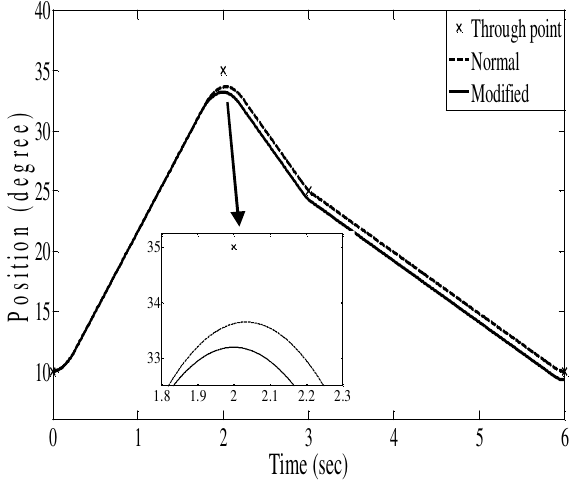
Fig. 4. Trajectories of normal and modified